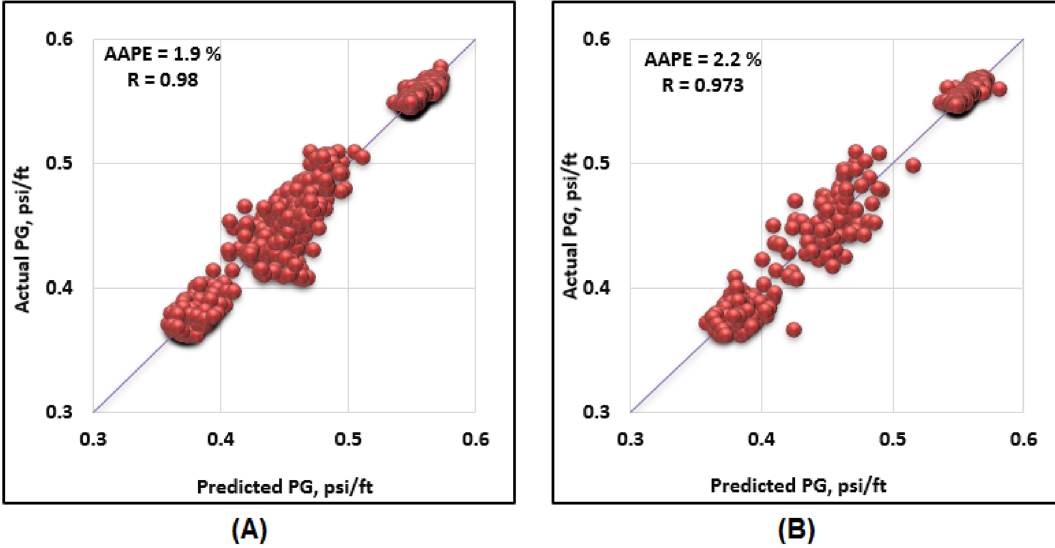
Figure 7. Cross-plots of the estimated versus recorded target values ( A ) training, and ( B ) testing (ANN